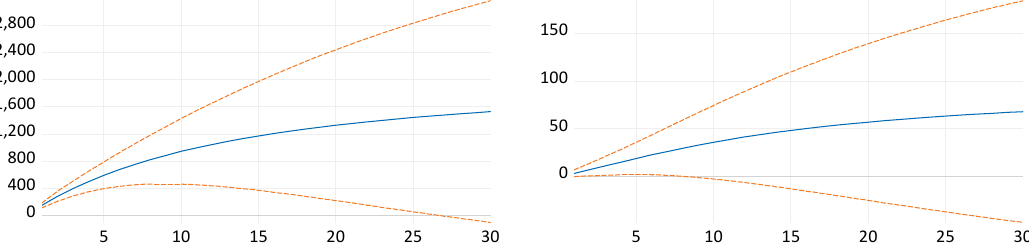
Figure 5. Accumulated responses of volatility in equity indices to structural innovations in VIX. Estimates and two standard deviation confidence band are in solid and dotted lines. SVAR lag order is one. Long-run identification restrictions are imposed. 24 June 2013–12 August 2015.